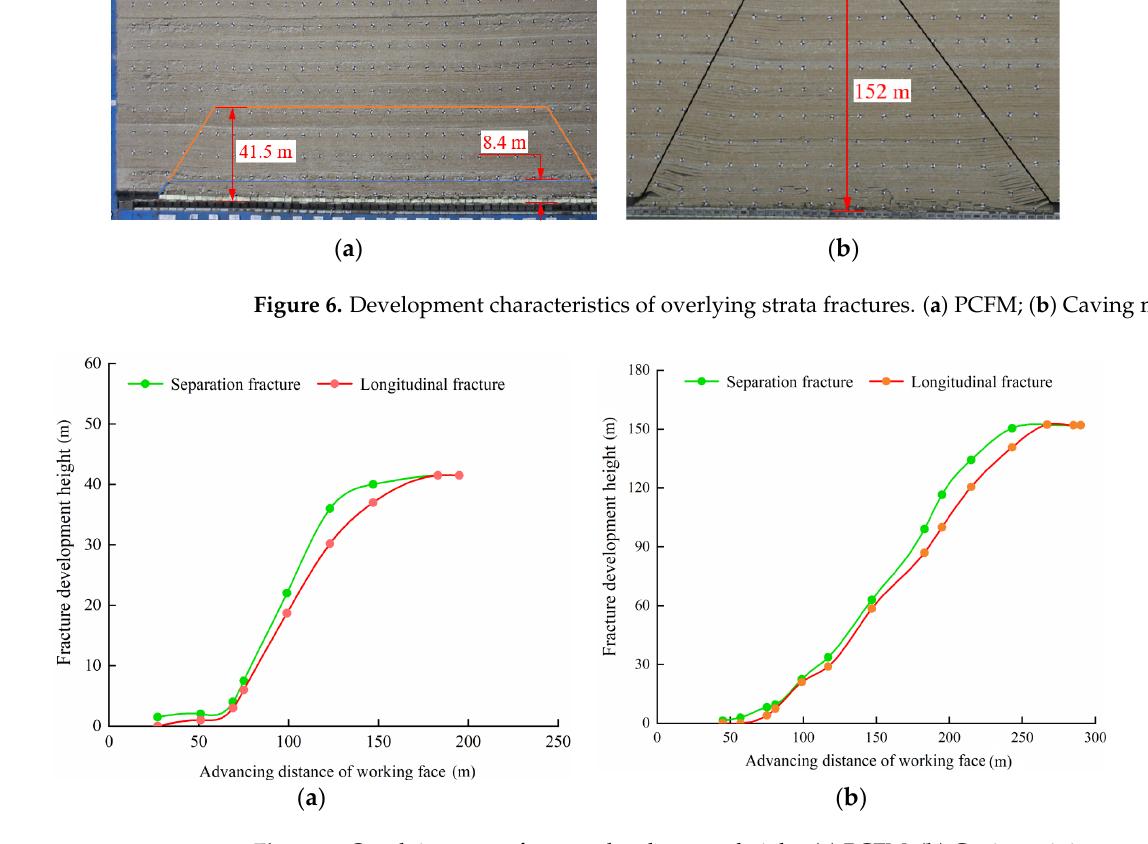
Figure 7. Overlying strata fracture development height. ( a ) PCFM; ( b ) Caving mining.